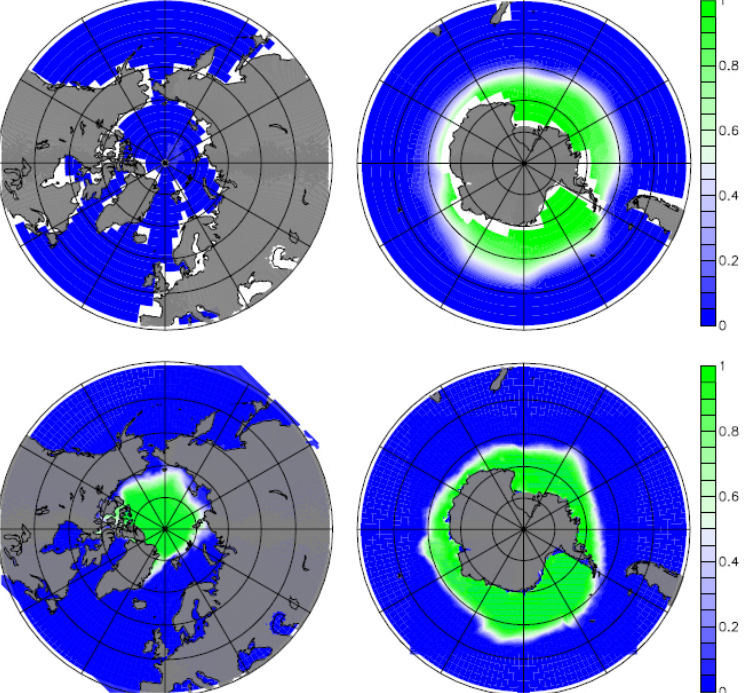
Fig. 12. Continued. The sea ice cover fraction in September in the Arctic (left) and the Antarctic (right). The top row shows the SPEEDO ensemble mean and bottom row the data from Cosimo